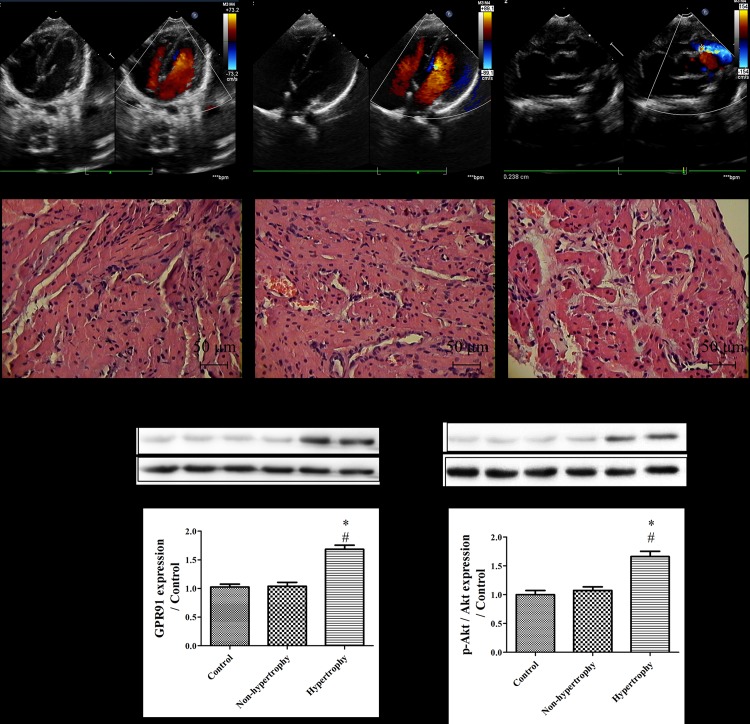
GPR91-PI3K/Akt signaling also exists in the human heart.A: Representative images of echocardiographic data from control, hypertrophic and non-hypertrophic patients. B: Representative images of HE-stained RA sections from control, hypertrophic and non-hypertrophic patients. C: GPR91 expression as determined by western blot analysis of the RA of control, hypertrophic and non-hypertrophic patients. D: p-Akt/Akt expression as determined by western blot analysis of the RA of control, hypertrophic and non-hypertrophic patients. E: Bar graph showing GPR91 expression as determined by western blot analysis of the RA of control, hypertrophic and non-hypertrophic patients (n = 3). F: Bar graph p-Akt/Akt expression as determined by western blot analysis of the RA of control, hypertrophic and non-hypertrophic patients (n = 3); *P<0.05 compared to the control subjects; #P<0.05 compared to the non-hypertrophic patients.